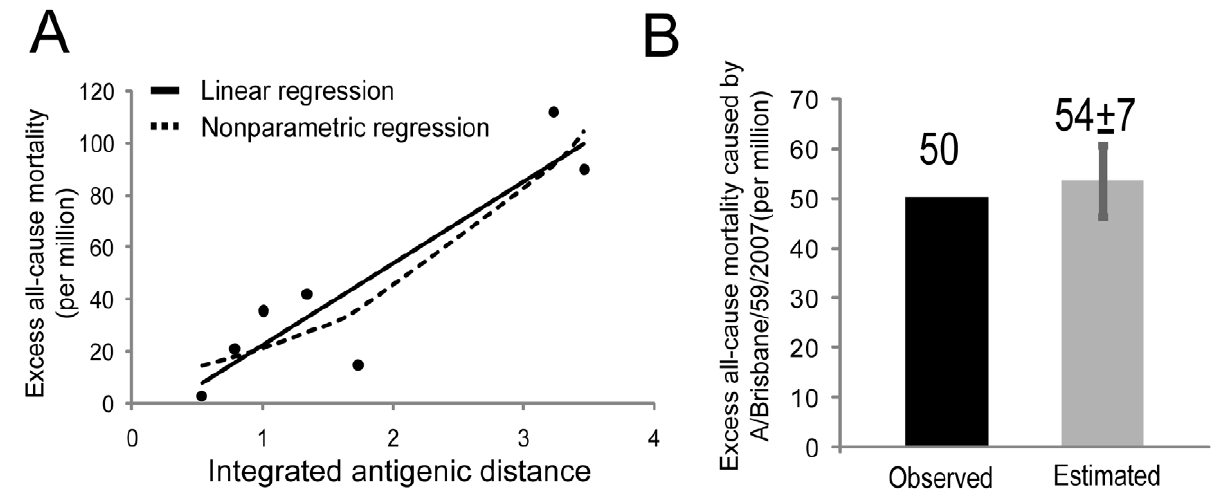
Figure 2. The quantitative relationship between the excess all-cause mortality and antigenic distance for A(H1N1). (A) The nonparametric (the dashed line) and ordinary linear (the black line) regression between the excess all-cause mortalities caused by A(H1N1) antigenic strains and their integrated antigenic distances to the previous first and second antigenic strains. The nonparametric regression is done using the local polynomials method (called loess method [11]). (B) The observed and estimated excess all-cause mortality for recent seasonal A(H1N1) virus A/ Brisbane/59/2007. The error bar shows the standard deviation of the prediction.